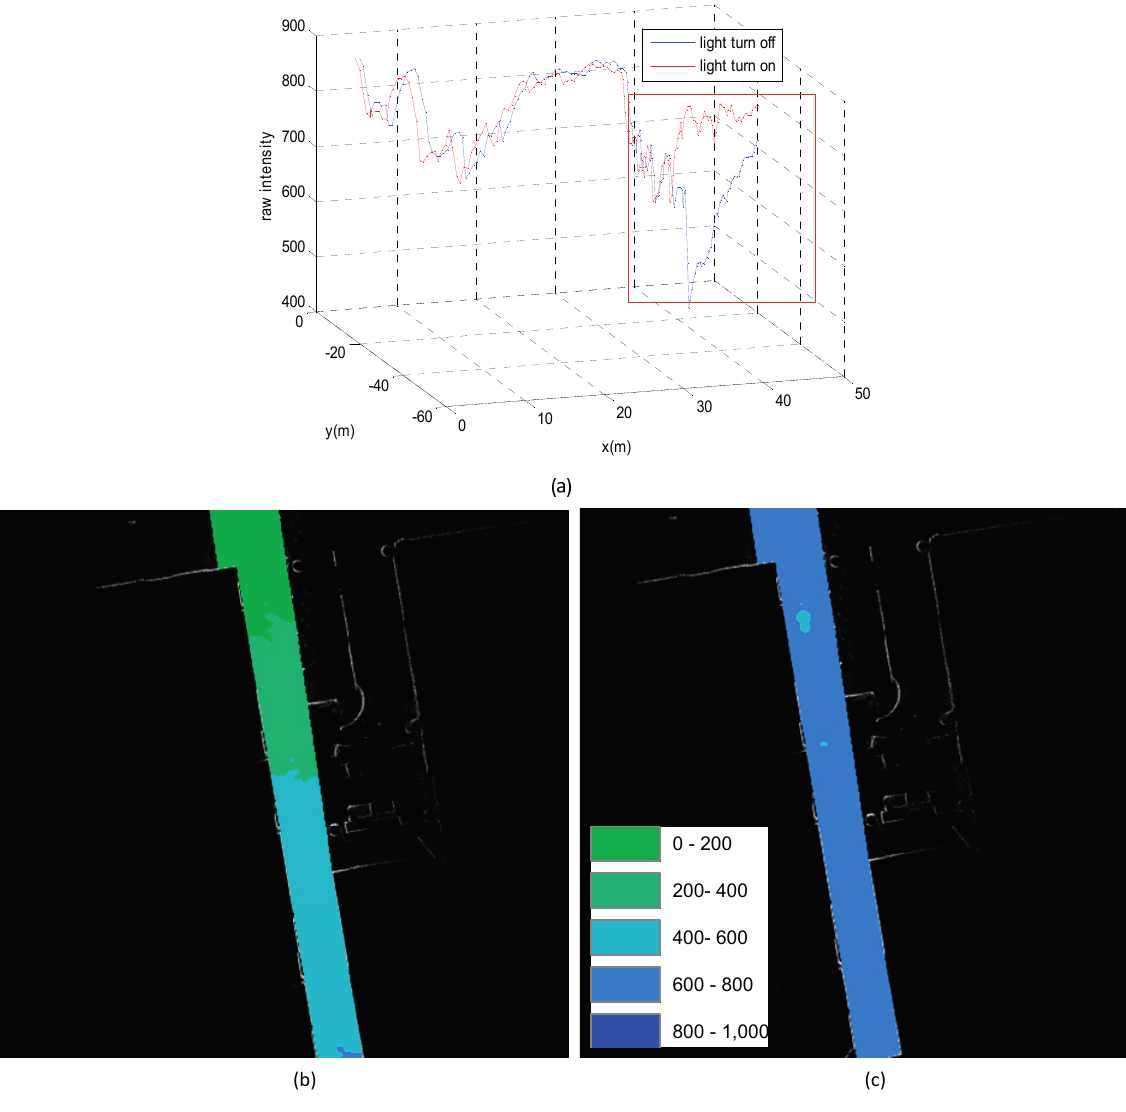
Figure 12. ( a ) 3D plot of light intensity variation detection; ( b ) the light intensity RSSI map with lights turned off; ( c ) the light intensity RSSI map with lights turn